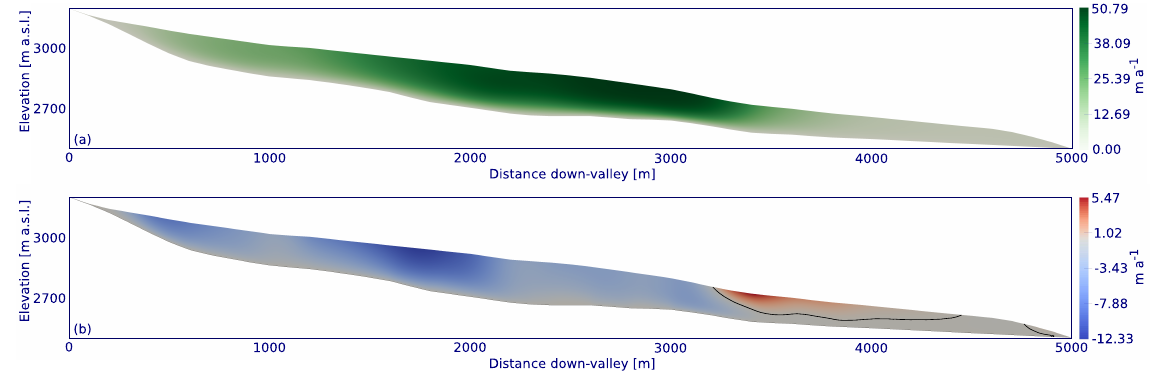
Figure 3. Velocity components computed with icetools for the 2-D long profile of Haute Glacier d’Arolla. (a) Horizontal velocity (myear − 1 ) and (b) vertical velocity (myear − 1 ) and contour line of zero vertical velocity in grey.